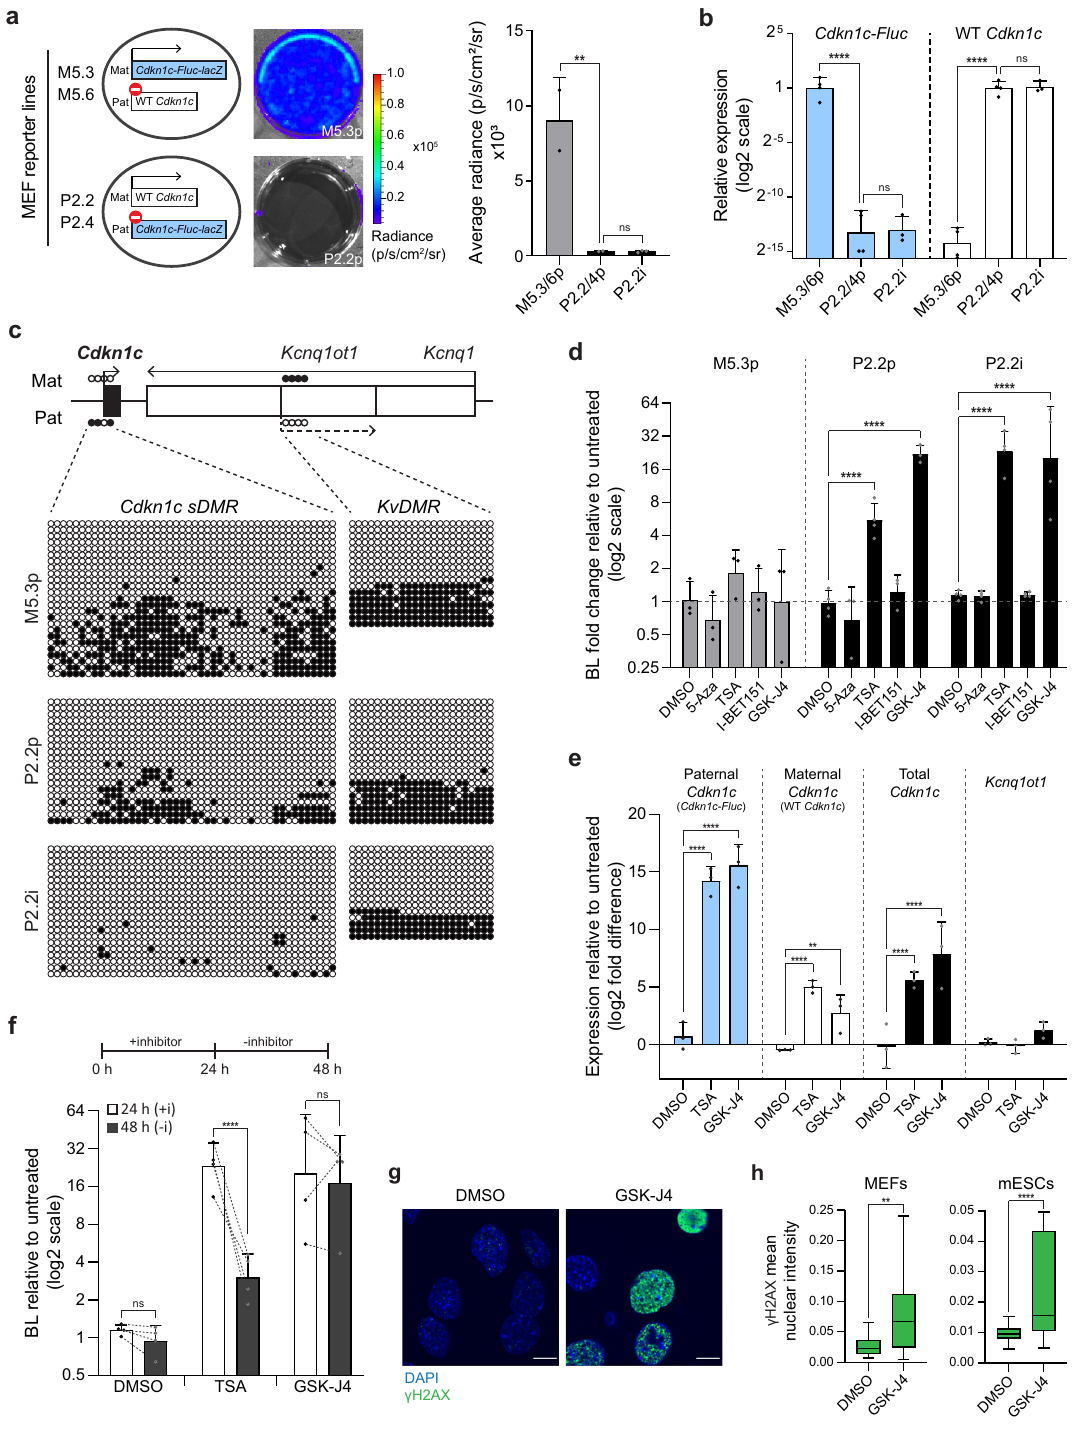
(Fig. 4h, right and Fig. S5e), indicating that the sustained de-repression of paternal Cdkn1c in both cell types may be related to cellular stress and a likely block of cell-cycle progression.